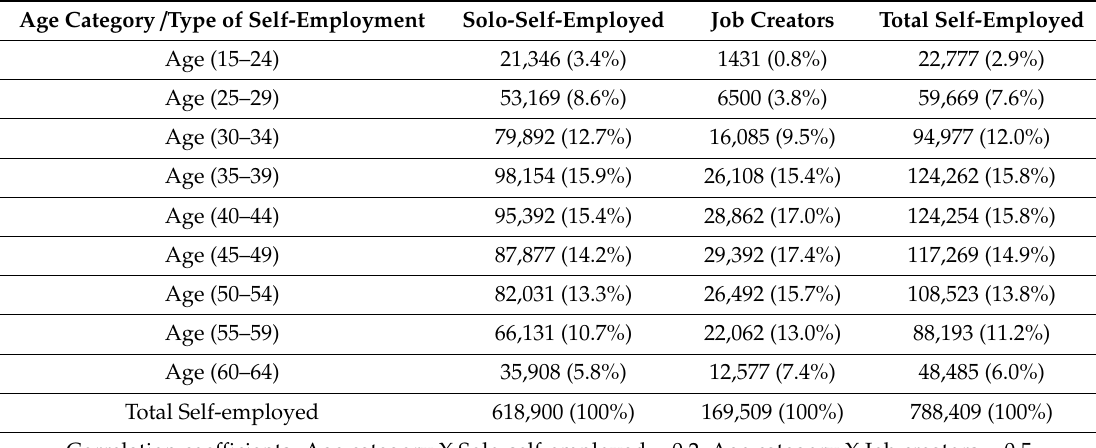
Table 2. Association between age and type of self-employment (age range 15–64 years; absolute numbers and column percentage shares in